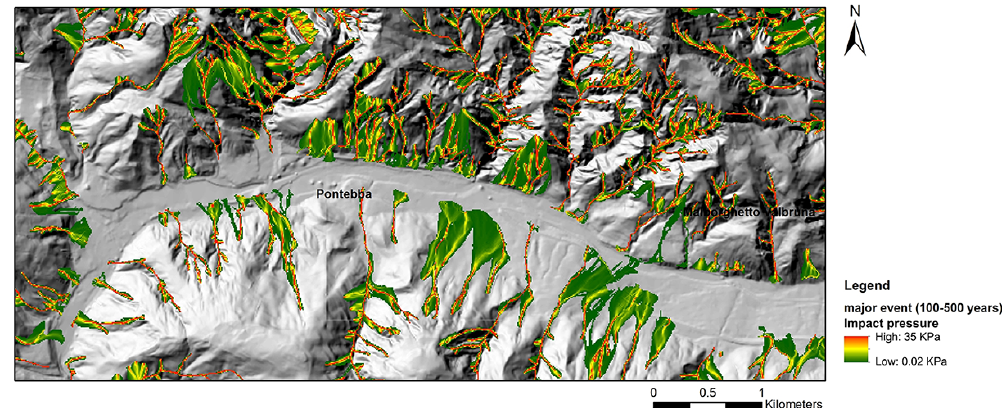
Figure 10. Debris flow (maximum intensity) of major event with return periods of 100–500 years (Hussin et al., 2014b).